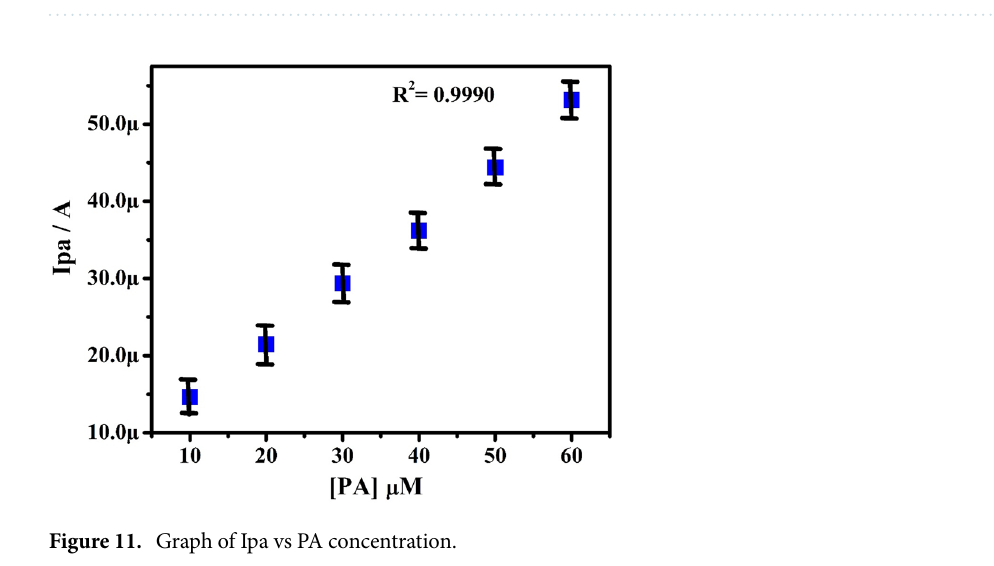
Figure 10. CVs for PA at different concentrations (10–60 µM) in PBS (0.2 M, pH 7.4) at PoOCD/MCPE.